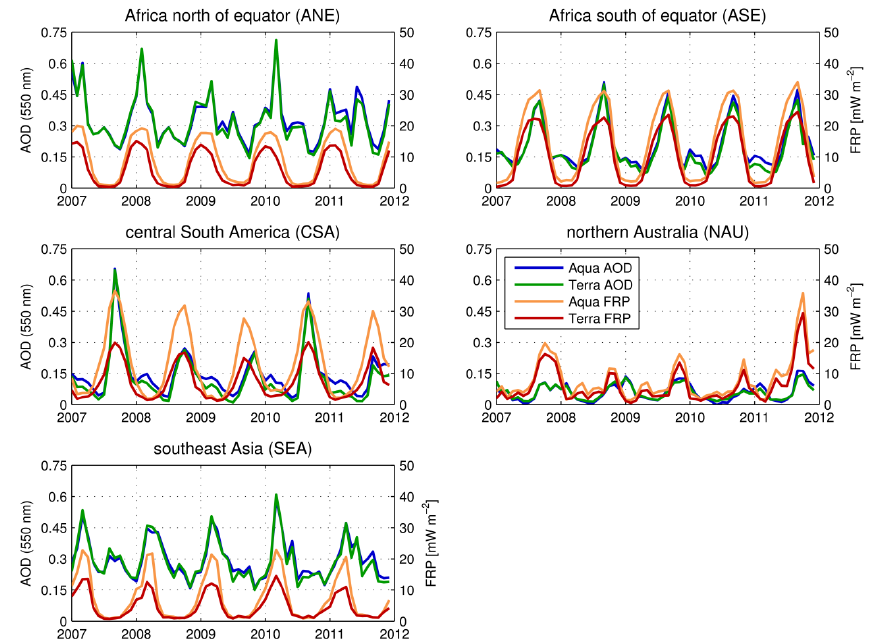
Fig. 12. Temporal variability of MODIS Terra (red) and MODIS Aqua (orange) derived FRP and MODIS Terra (green) and MODIS Aqua (blue) satellite-derived AOD for ANE, ASE, CSA, NAU, and SEA.